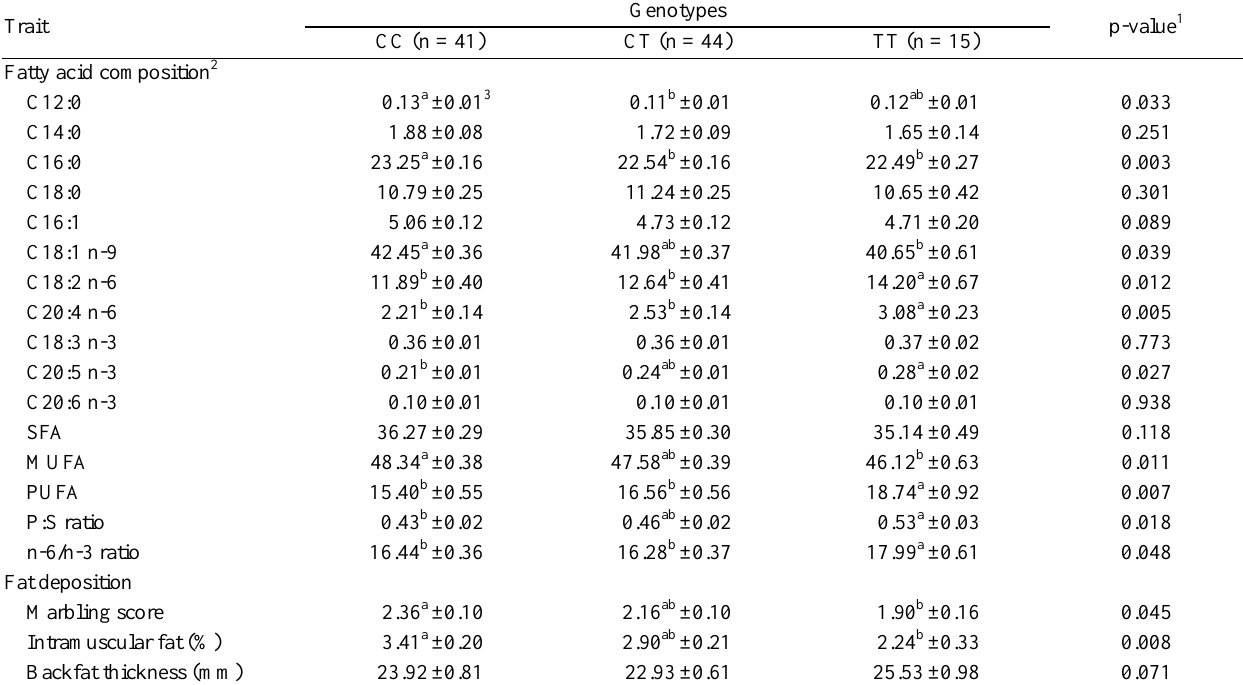
Table 5. The least squares analysis of different genotypes of c.*2041T>C SNP in the 3′ untranslated region of the stearoyl-CoA desaturase gene with fatness quality traits in Berkshire pigs Trait